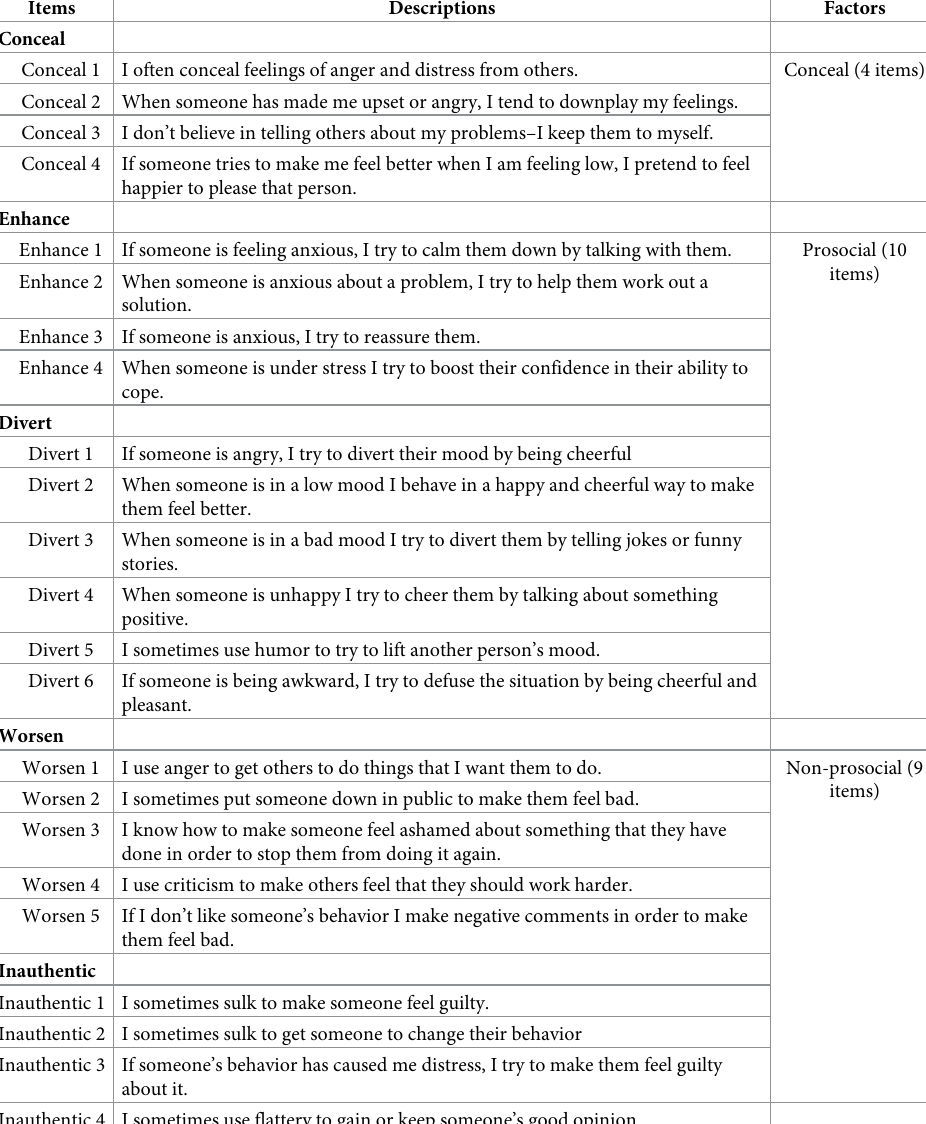
Table 4. Item descriptions of MEOS-SF (23 items). Items Descriptions